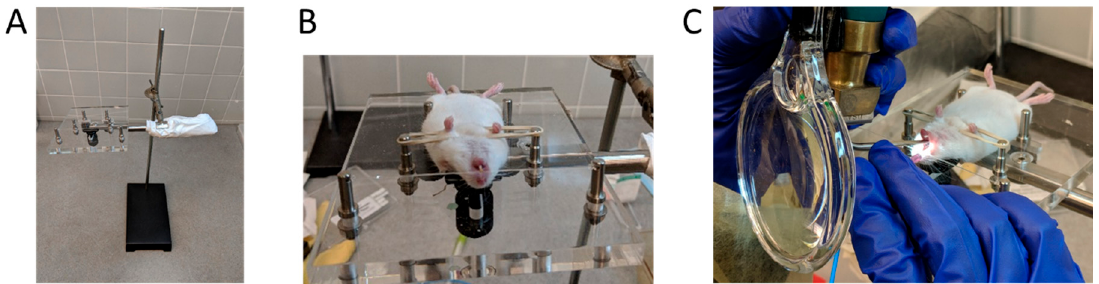
Figure 1. Steps for mouse intubation. ( A ) Set-up of the intubation platform; ( B ) Anesthetized mouse